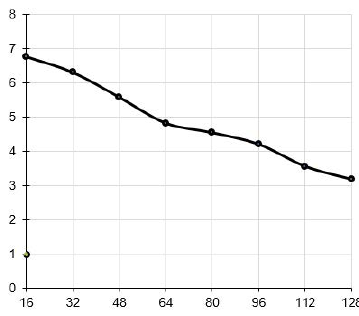
Figure 17. Global Response time vs. maximum number of VMs in the private cloud.